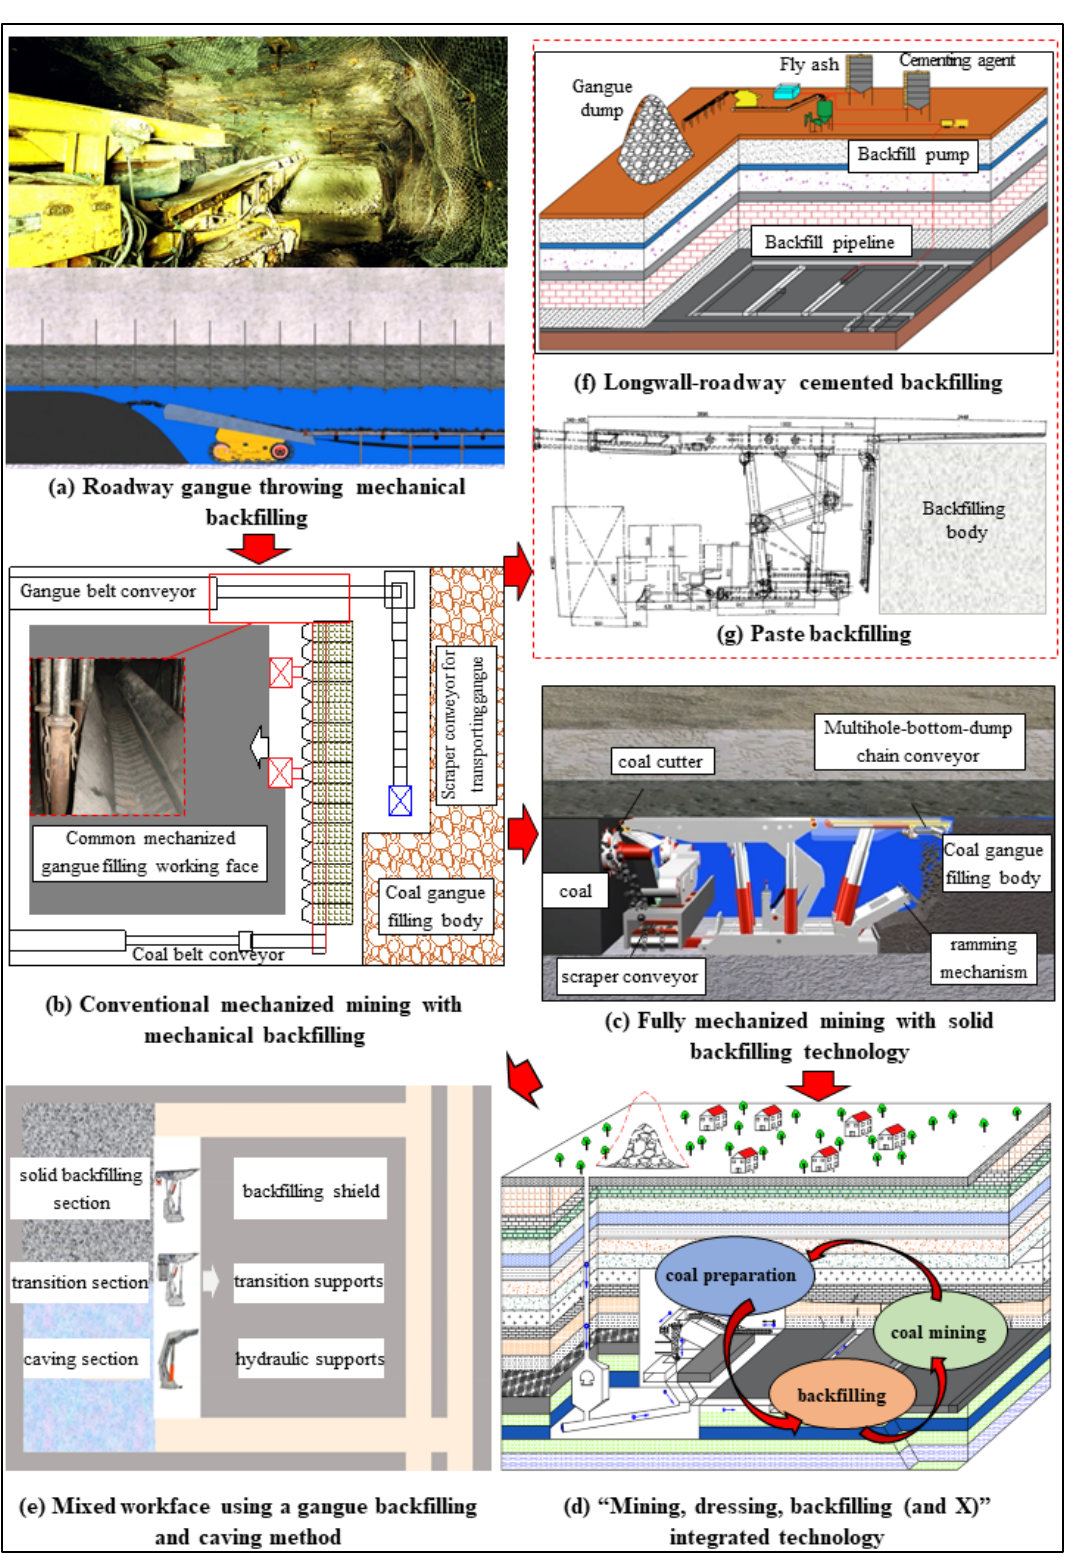
Figure 4. The history of the gangue backfilling technology development.